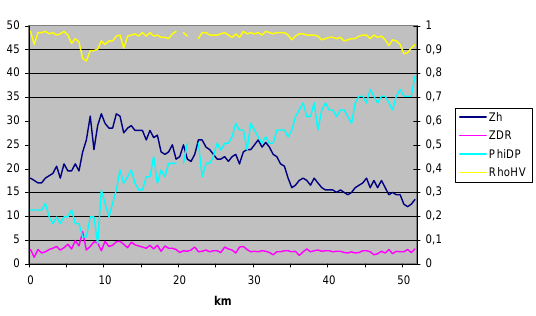
Fig. 6 : Polarimetric variables along a single beam at 2.0° elevation. Polarimetric parameters along a beam at -0.8° elevation